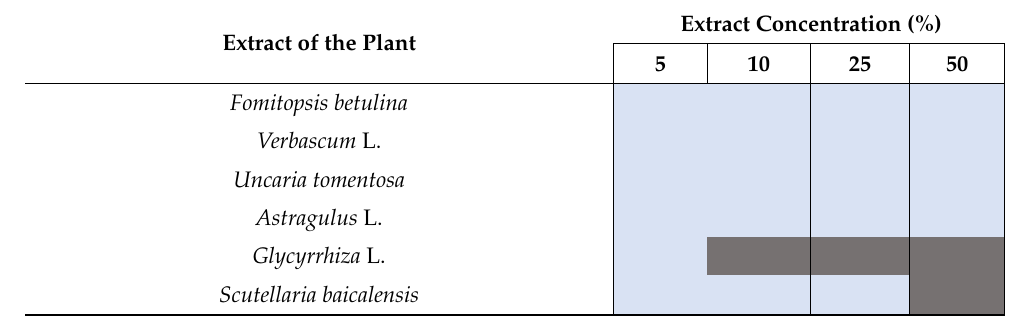
Table 3. The influence of plant extracts on E . coli growth.